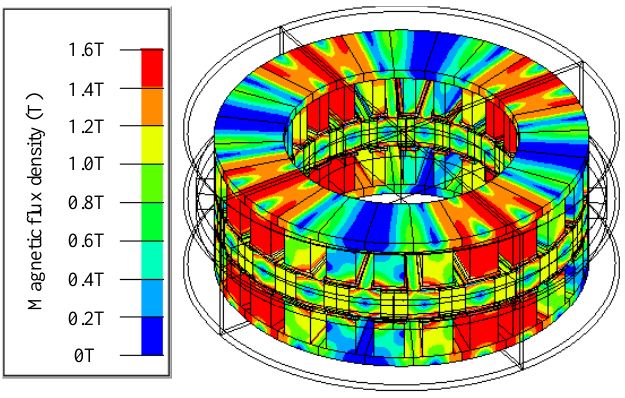
Figure 14. 3D finite element method (FEM) simulation model and the magnetic flux density distribution at no-load of the TLST AFIPM machine with flux barriers.